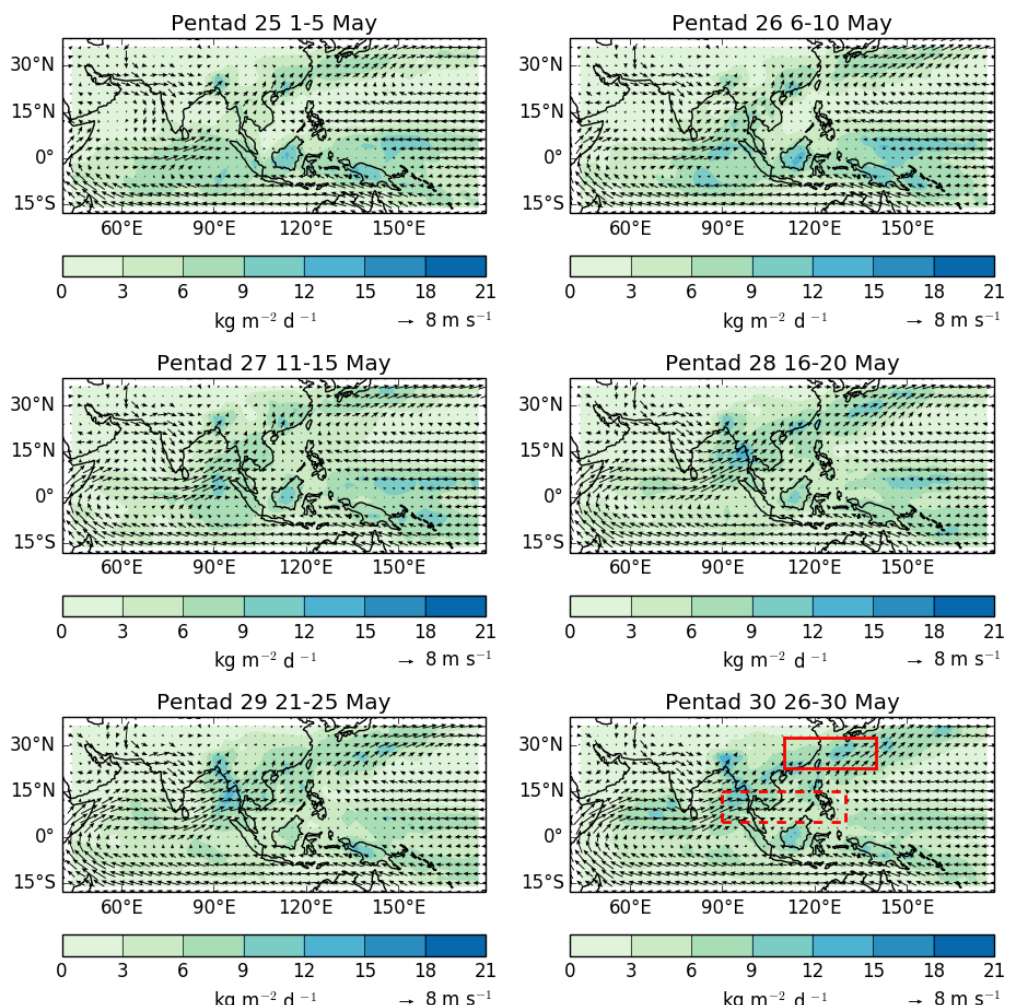
Figure 9. Pentad evolution of 850hPa winds (ERA-Interim) and rainfall (GPCPv2) through the broad-scale seasonal transition towards the Asian summer monsoon season, heralded by the reversal of wind direction over the South China Sea which typically occurs around pentad 28 (Wang et al., 2004). The red boxes in the final panel indicate the northern (solid) and southern (dashed) regions that are used in the calculation of the East Asian summer monsoon index (see Wang et al., 2008, and Fig.